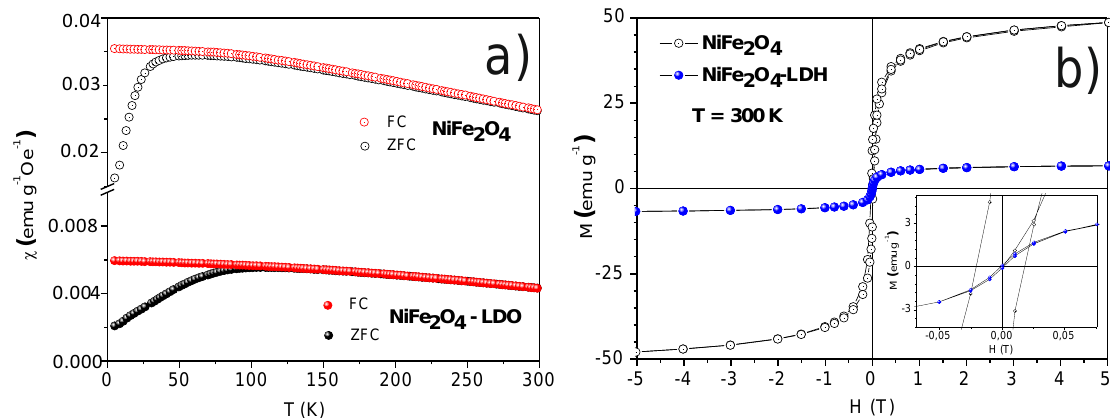
Figure 3. ( a ) Temperature dependent magnetic susceptibility of NiFe 2 O 4 NPs and NiFe 2 O 4 -LDH composite. ( b ) Hysteresis loops for NiFe 2 O 4 NPs and NiFe 2 O 4 -LDH composite at room temperature (RT). Inset shows an enlargement of the main